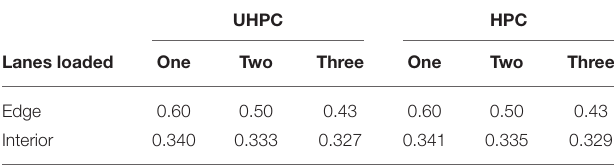
TABLE 2 | AASHTO live load distribution factors for UHPC and HPC.